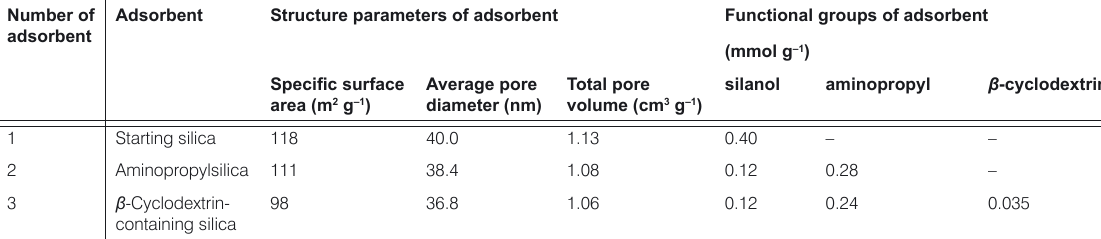
Table 2. Chemical composition of surface layer and structure parameters for the silica